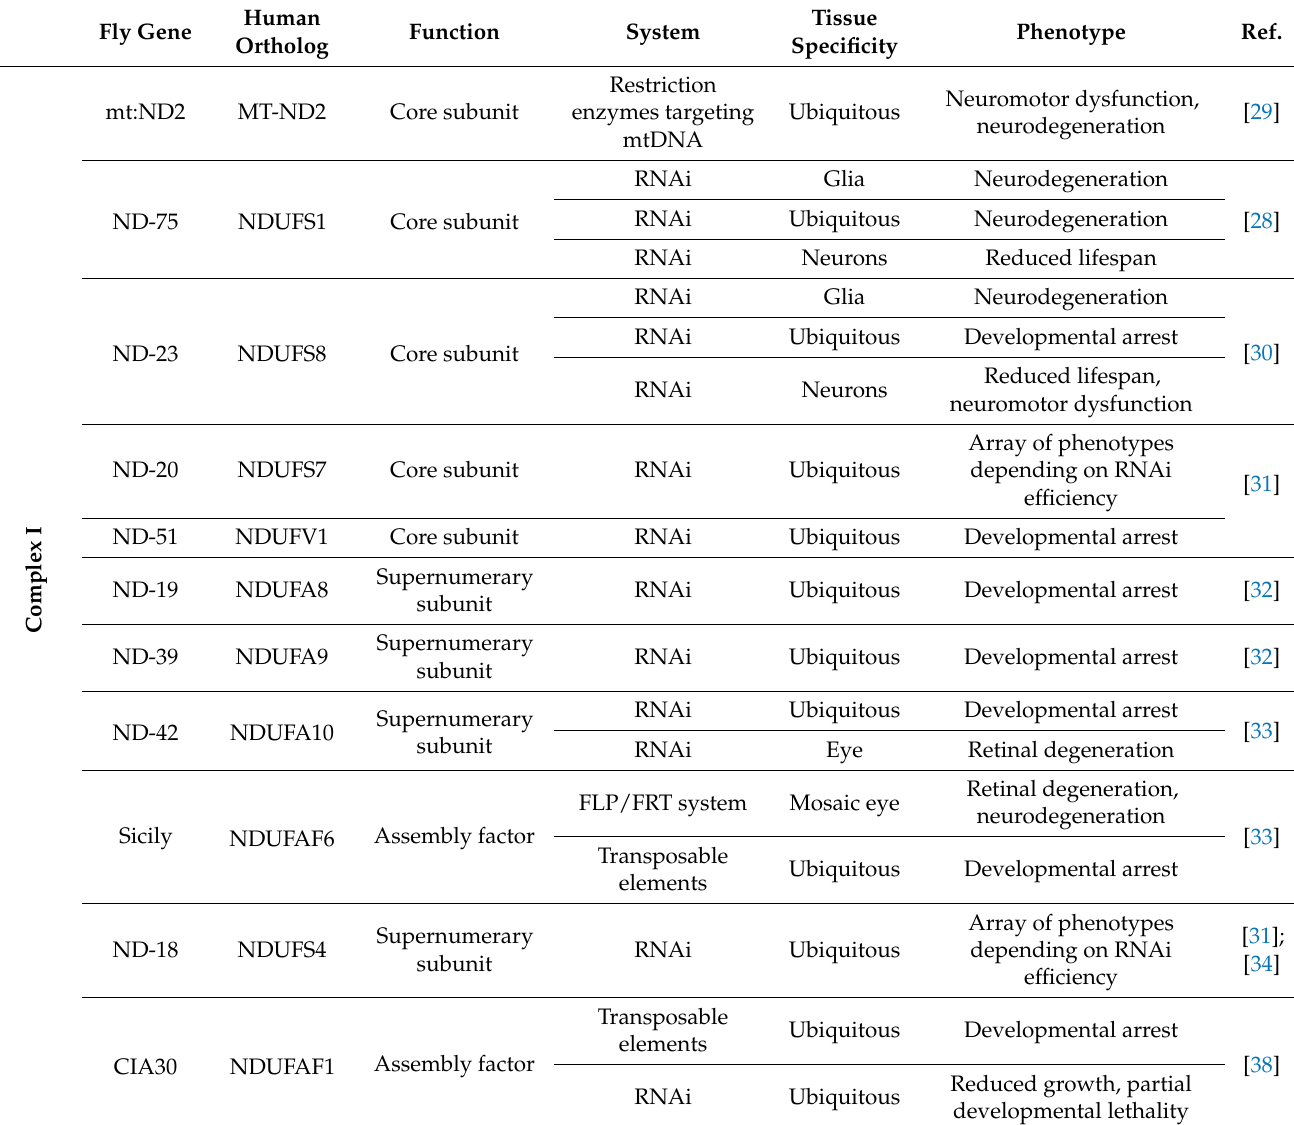
Table 1. Fly models of respiratory chain